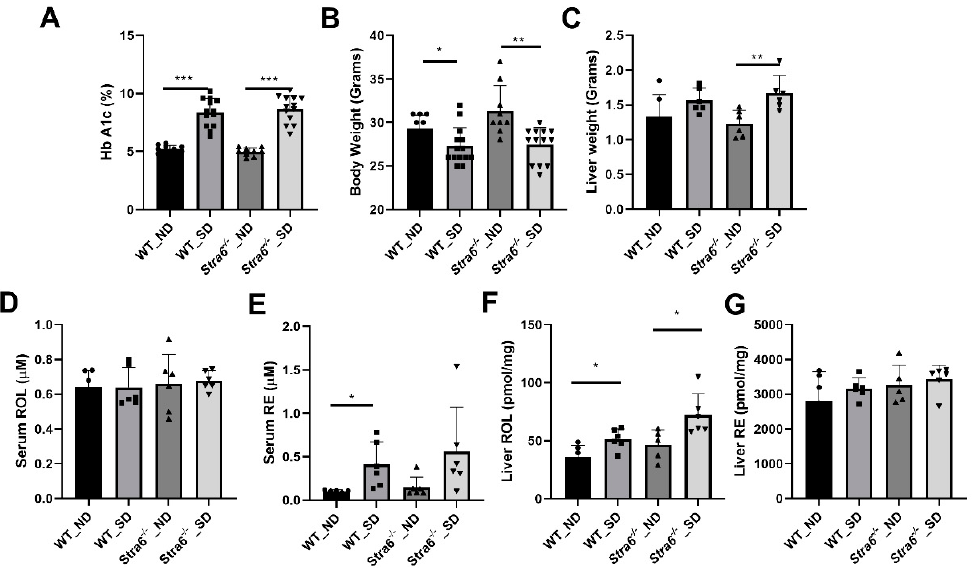
Figure 1. Experimental setup of the intervention study. Two-month-old WT and Stra6 -/--/- mice were injected with STZ for five consecutive days. Diabetes was declared after the measurement of fasting blood glucose and HBA1c. Eight weeks post-diabetes, mice were sacrificed for short-term experiments. The remaining mice were monitored for an additional 22 weeks and analyzed after 30 weeks of diabetes. In all experiments, equal numbers of non-diabetic mice served as controls.